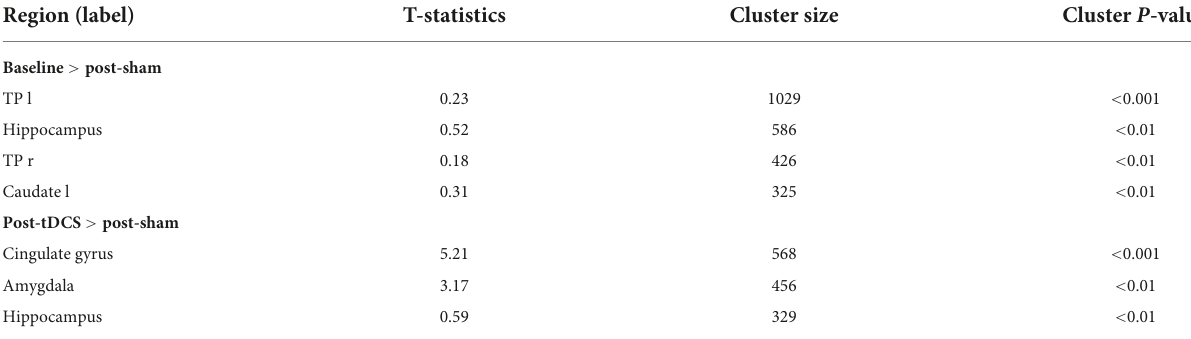
TABLE 1 Main effects of hypoxic environment and tDCS on FC of the thalamic network. Region